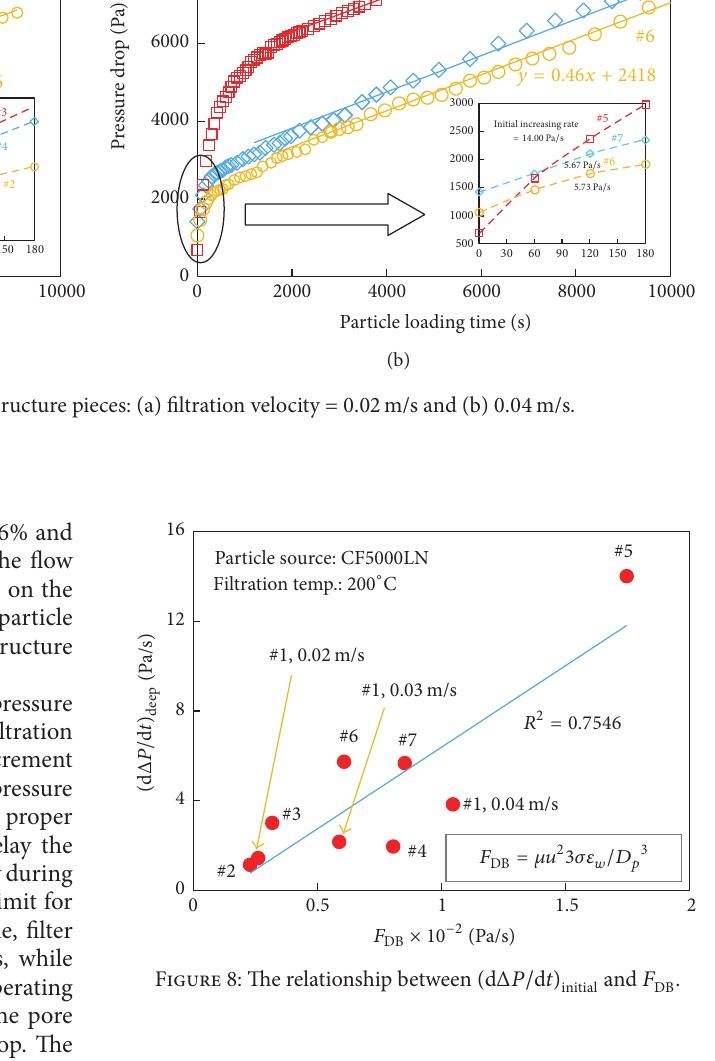
to correlate ( d Δ𝑃/ d 𝑡) initial with 𝑢 , 𝜀 𝑤 , 𝐷 𝑝 , 3𝜎 , and the exhaust dynamic viscosity 𝜇 as follows: